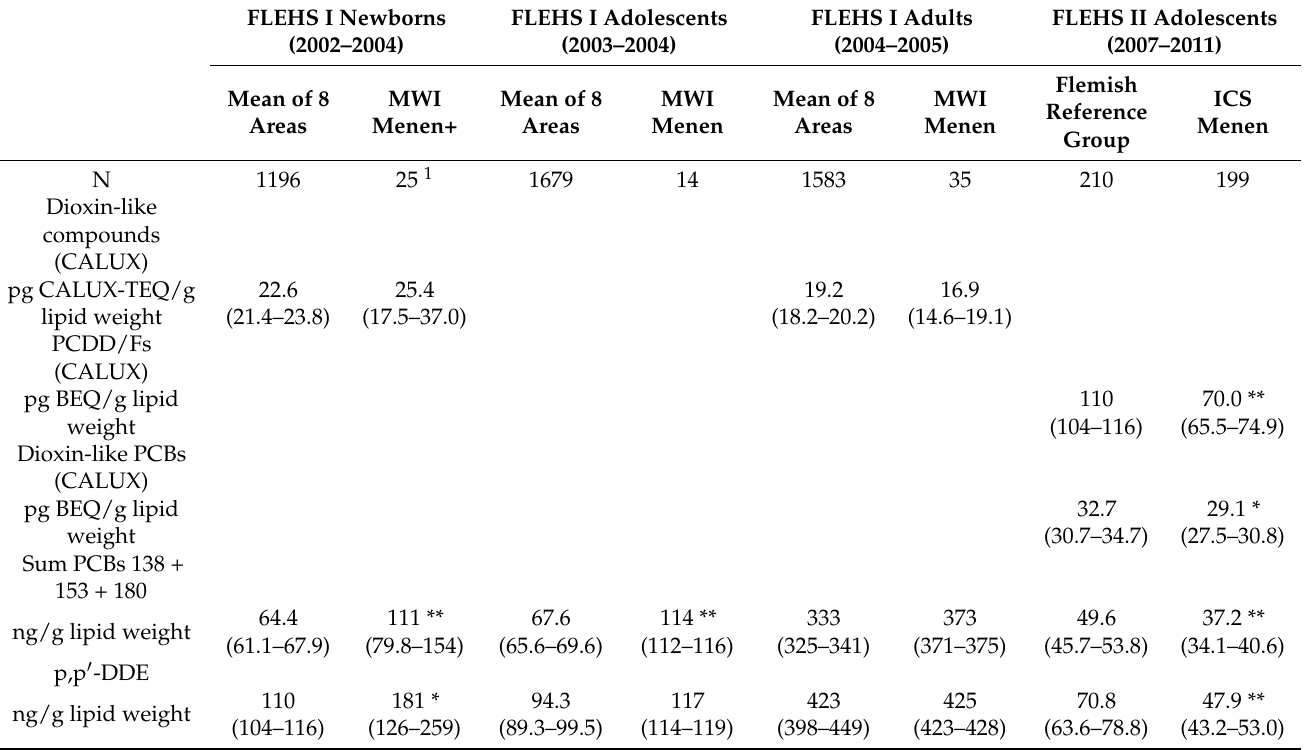
Table 2. Comparison of the geometric mean concentrations (95% confidence interval) of dioxin-like compounds, marker PCBs and p,p (cid:48) -DDE in newborns, 14–15 year-old adolescents and 50–65 year-old adults residing near the ICS of Menen with the reference mean values of all eight areas combined (FLEHS I 2002–2006) and the Flemish reference mean (FLEHS II 2007–2011). FLEHS I results adjusted for age, sex and smoking, FLEHS II results are raw